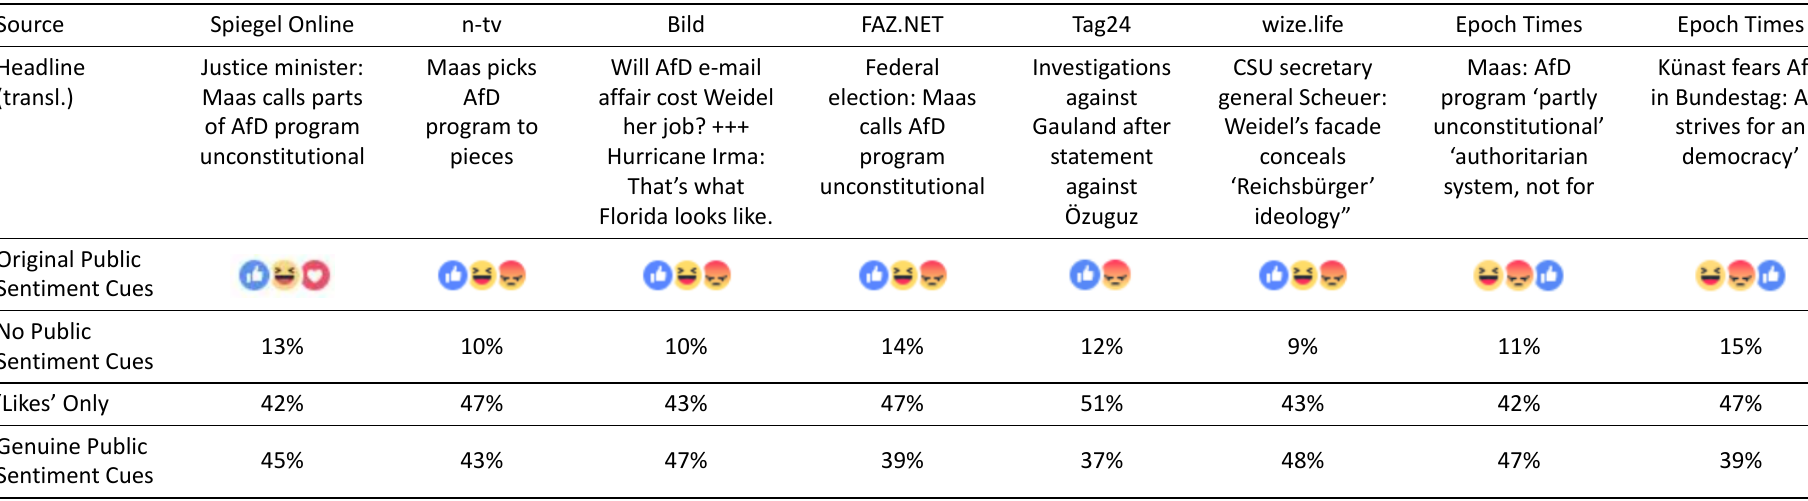
Table 1. Overview of AfD-critical posts and random assignment of public sentiment cues per post ( N =